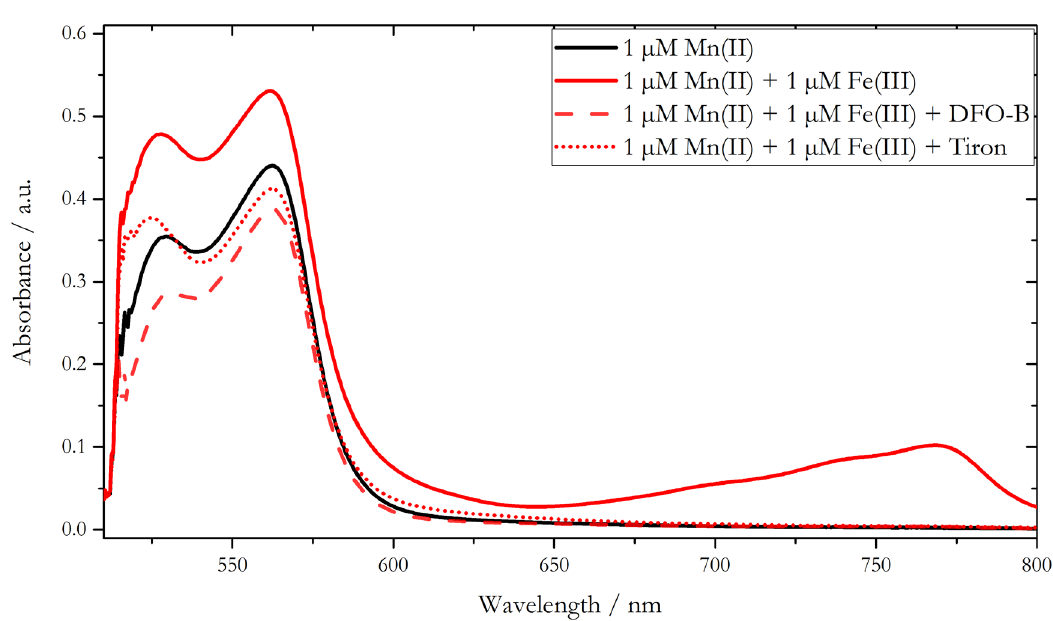
Figure 3. Absorbance spectra of a 1 µM Mn(II) standard solution and 1 µM Mn(II) solutions containing 1 µM Fe(III) with DFO-B and Tiron, added as Fe masking agents. All spectra were measured using 0.8 mM PAN reagent prepared with 2% v/v